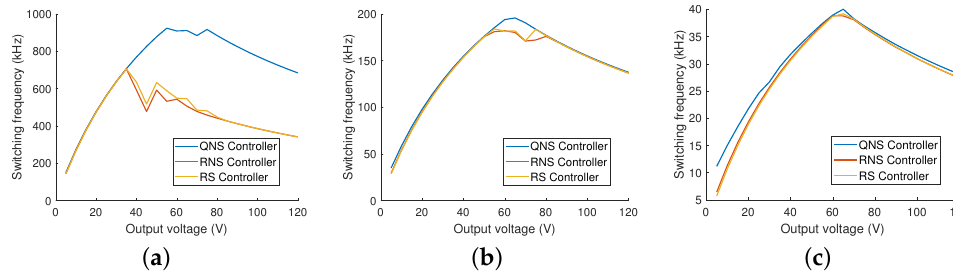
Figure 3. Switching frequency variation with Quadratic Non-Sampled (QNS) Controller, Robust Non-Sampled (RNS) Controller, and Robust Sampled (RS) Controller ( a ) Switching rule at 1 MHz ( b ) Switching rule at 200 kHz, ( c ) Switching rule at 40 kHz.